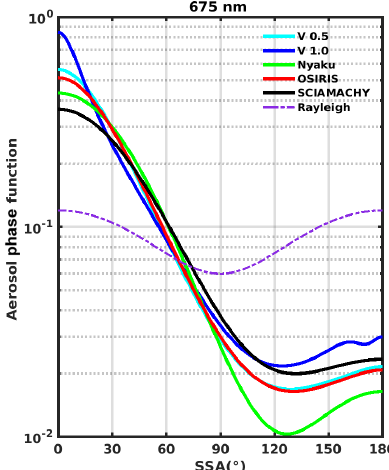
Figure 9. The aerosol phase function at 675nm as a function of SSA (or (cid:50) ) for the aerosol size distributions listed in Tables 1–2.